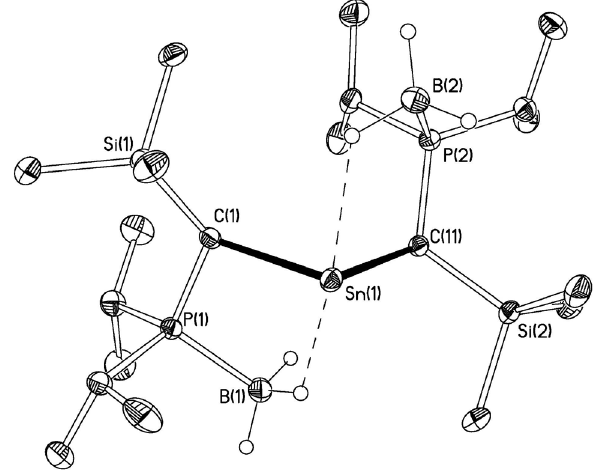
Figure 2 Molecular structure of 7 with 40% probability ellipsoids and with C-bound H atoms omitted for